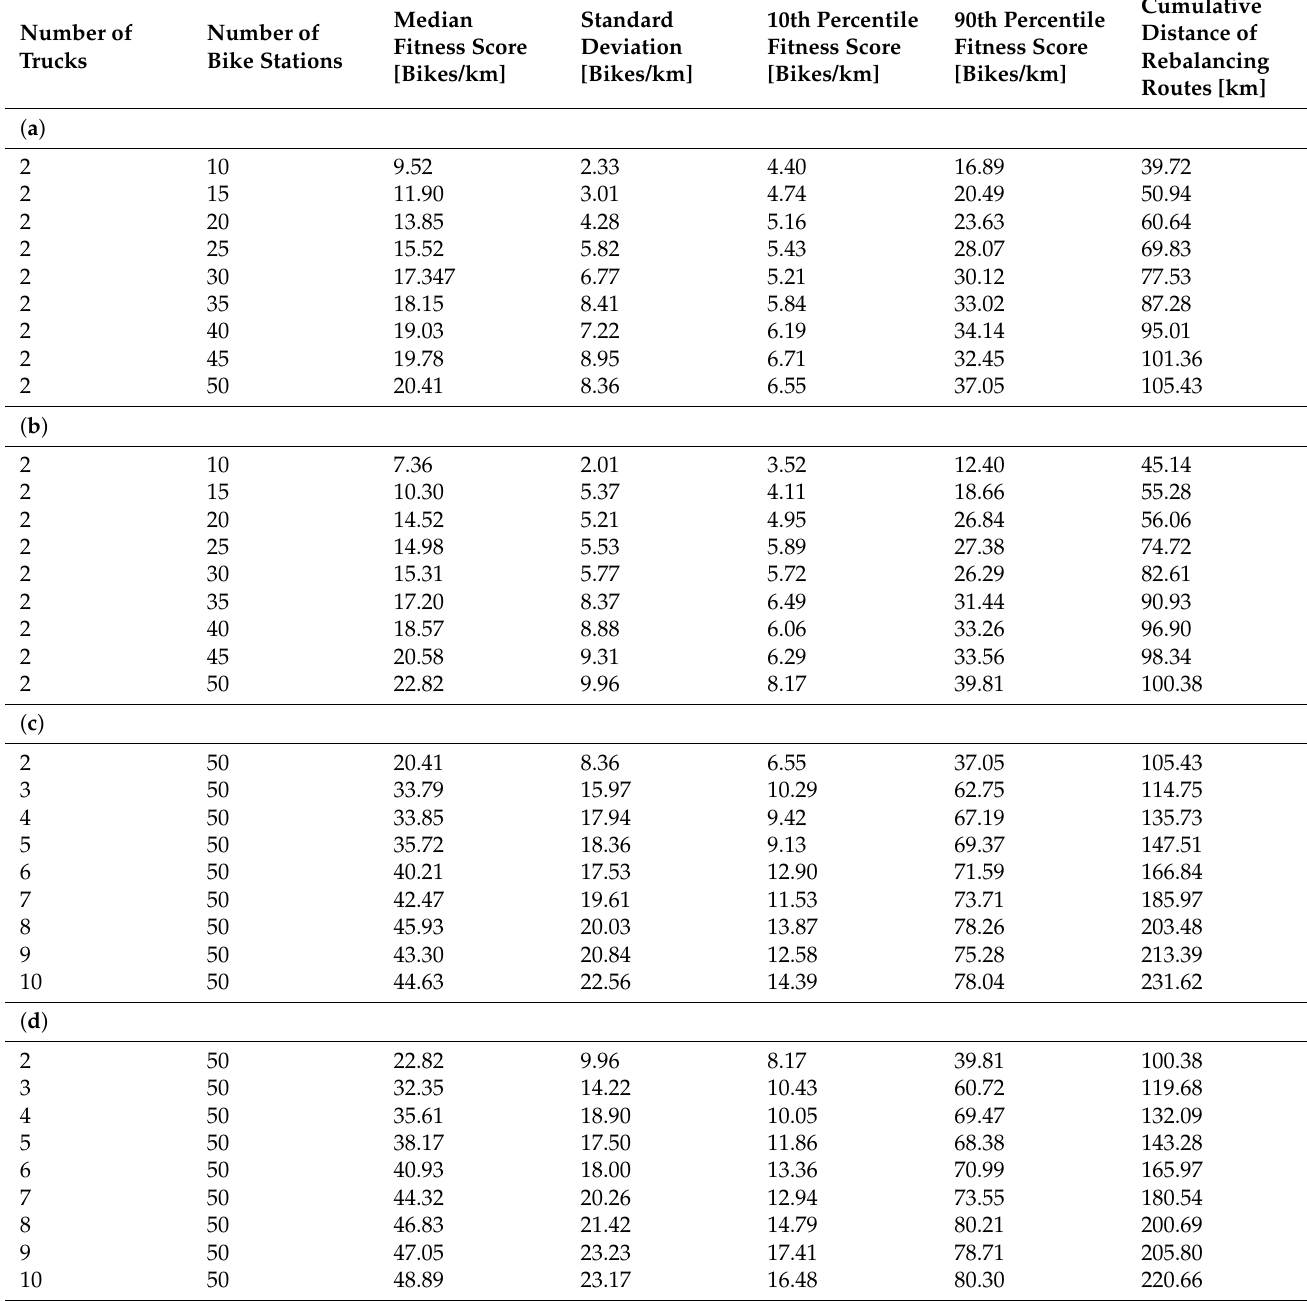
Table 7. ( a ) Performance of the FLCGA for different numbers of bike stations to rebalance. ( b ) Performance of the HHO for different numbers of bike stations to rebalance. ( c ) Performance of the FLCGA for different numbers of rebalancing trucks. ( d ) Performance of the HHO for different numbers of rebalancing